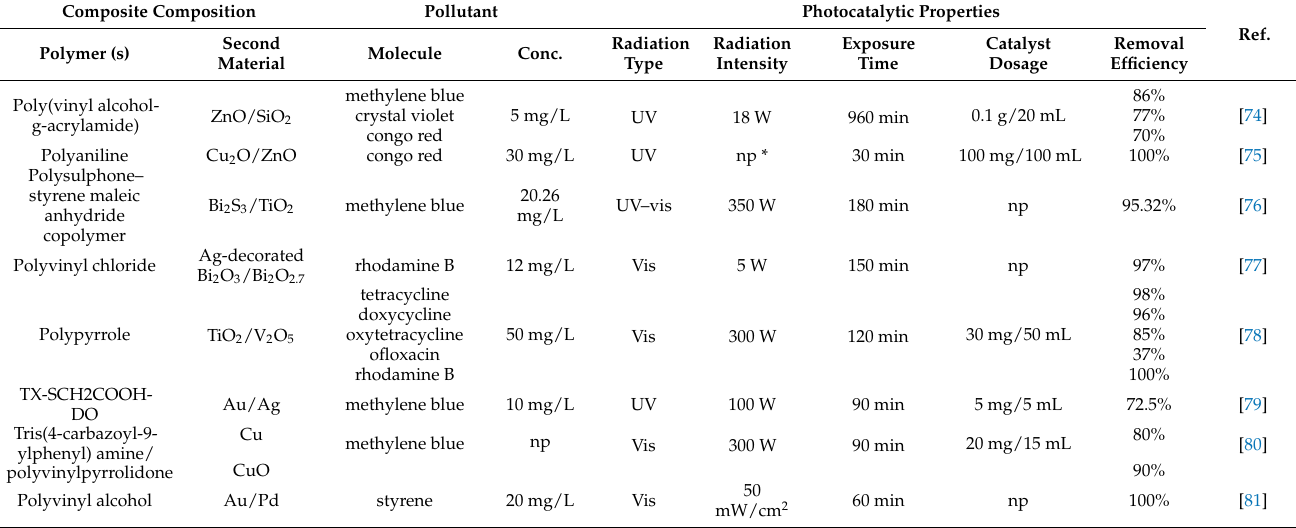
Table 2. Other polymer composite-based